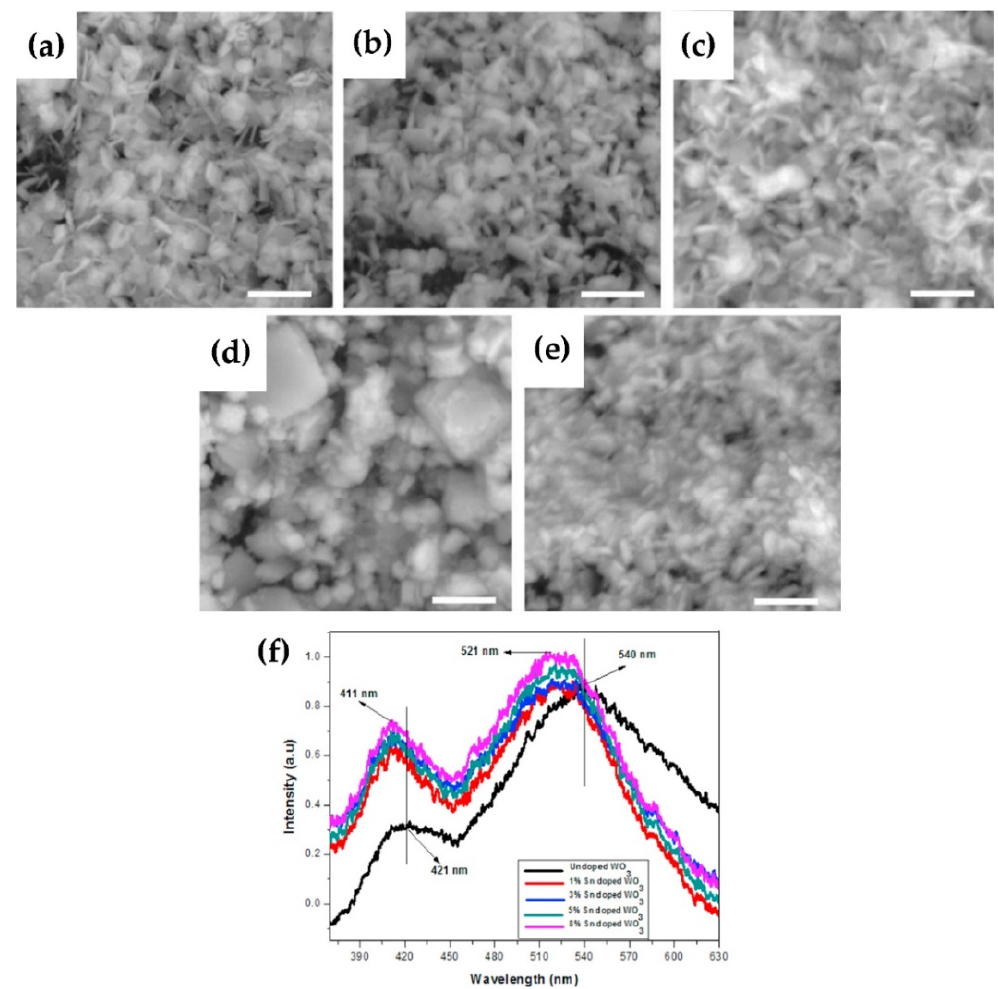
Figure 11. SEM images of ( a ) undoped ( b ) 1% ( c ) 3% ( d ) 5% and ( e ) 8% Sn doped WO 3 nanostructures. Scale bar is 500 nm. ( f ) PL spectra of undoped and Sn doped WO 3 nanostructures. Reproduced or adapted from [59].